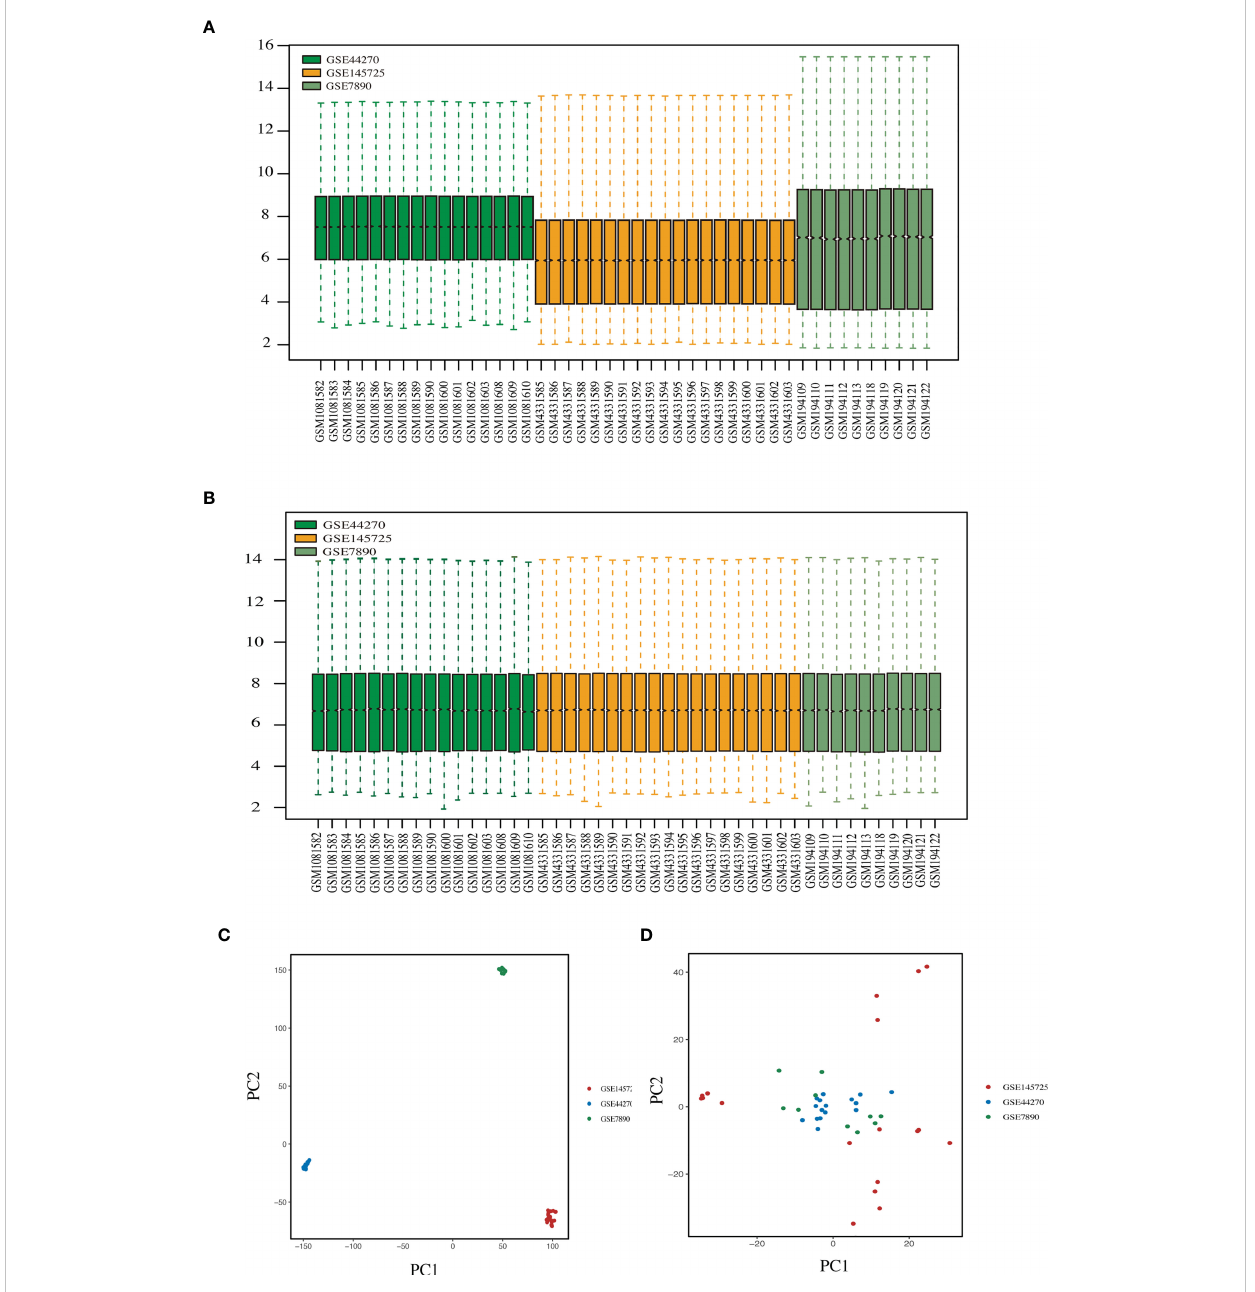
FIGURE 2 Combining different datasets. (A, B) Boxplots of mRNA expression distribution before and after removing batch effects. (C, D) PCA plots before and after removing batch